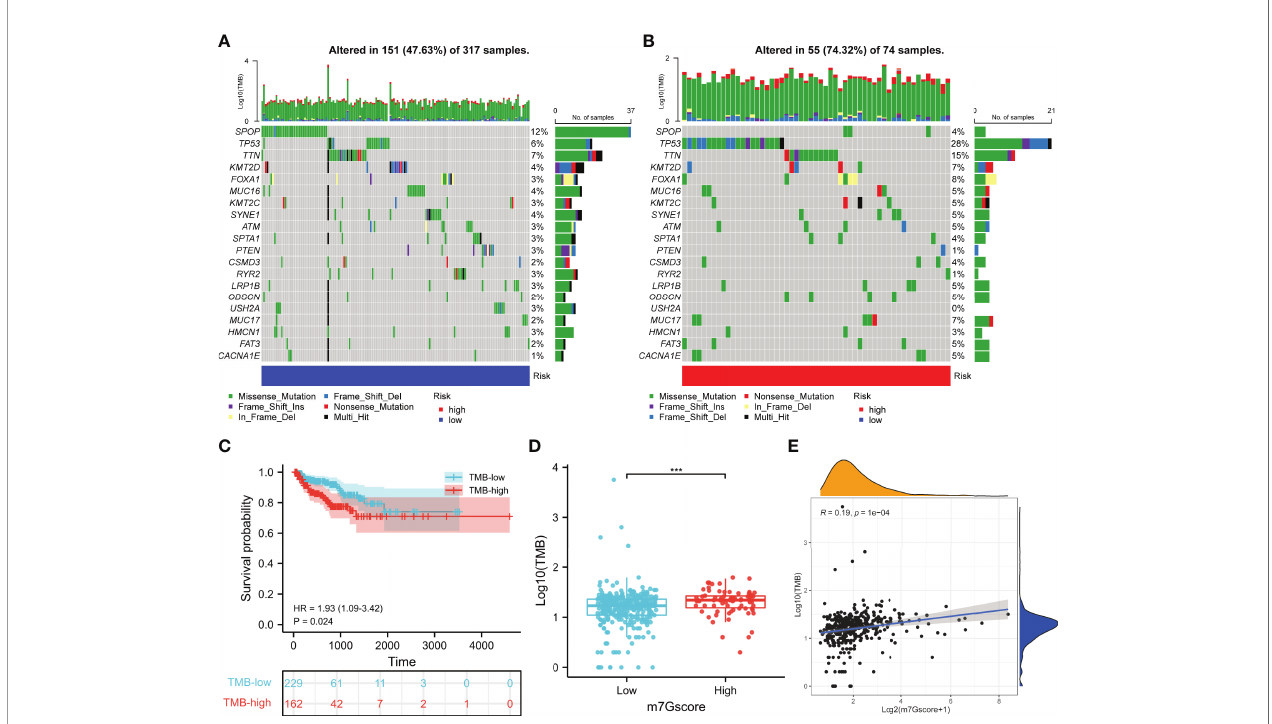
FIGURE 10 | Somatic mutation of the m7Gscore-de fi ned phenotypes. (A, B) Mutational spectrums consisted of the 20 most frequent mutation genes in the m7Gscore-de fi ned groups. (C) Correlation between TMB and BCR-free survival of PCa patients. (D, E) Relevance between m7Gscore and TMB with box plot (D) and correlation analysis (E) . TMB, tumor mutation burden; BCR, biochemical recurrence; PCa, prostate cancer. ***p <